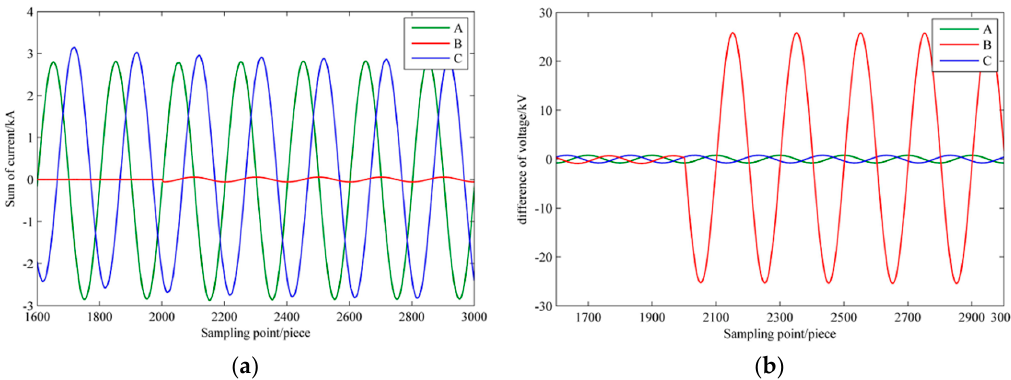
Figure 8. External fault with metallic grounding in phase B. ( a ) Sum of fault component current. ( b ) The voltage difference of the fault component.